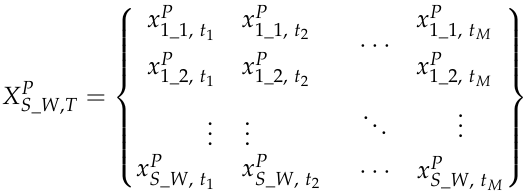
Figure 2. The framework of the proposed (Transformer-K-Means)-(ResNet-GCN-AttLSTM). As shown in Figure 1, the inflow and outflow at the different stations, even at the same station, are very different. Inflow prediction is more significant for avoiding congestion among stations. Thus, we use both the inflow and outflow data in the classification block to predict the inflow in the prediction block.